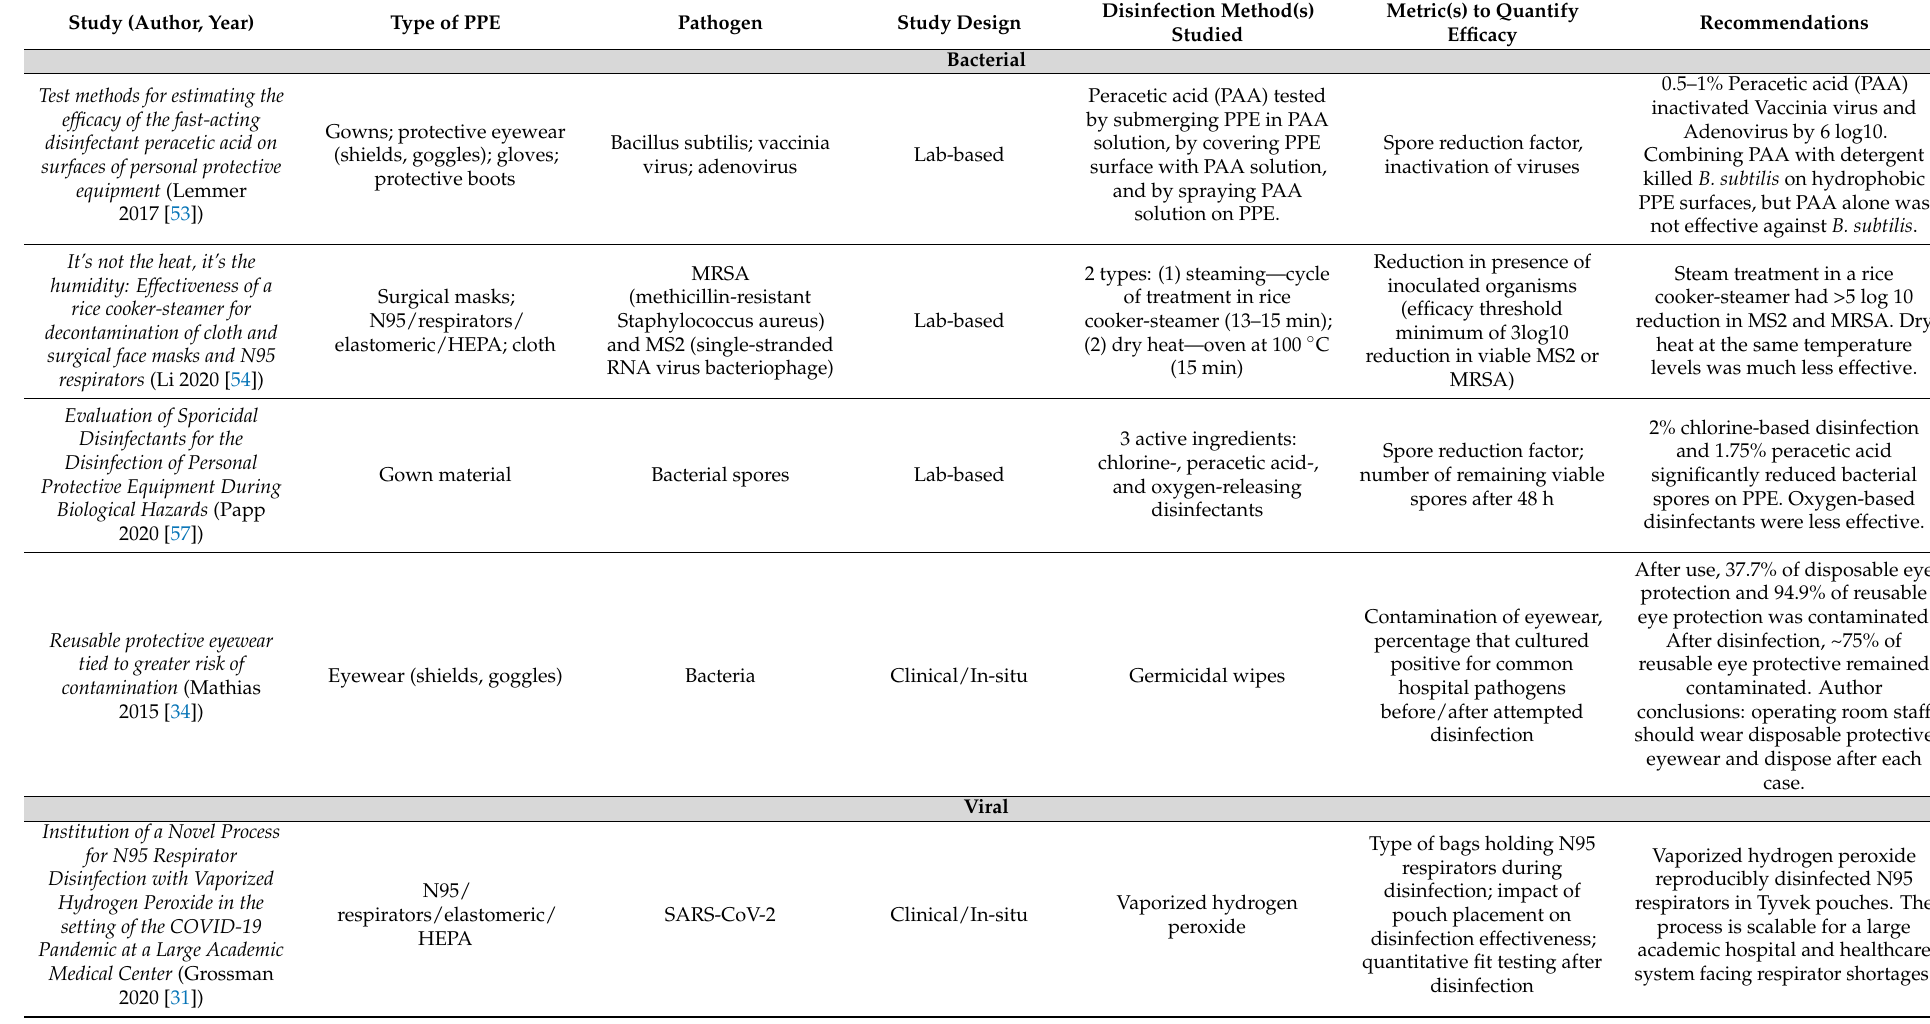
Table 2. PPE disinfection methods against